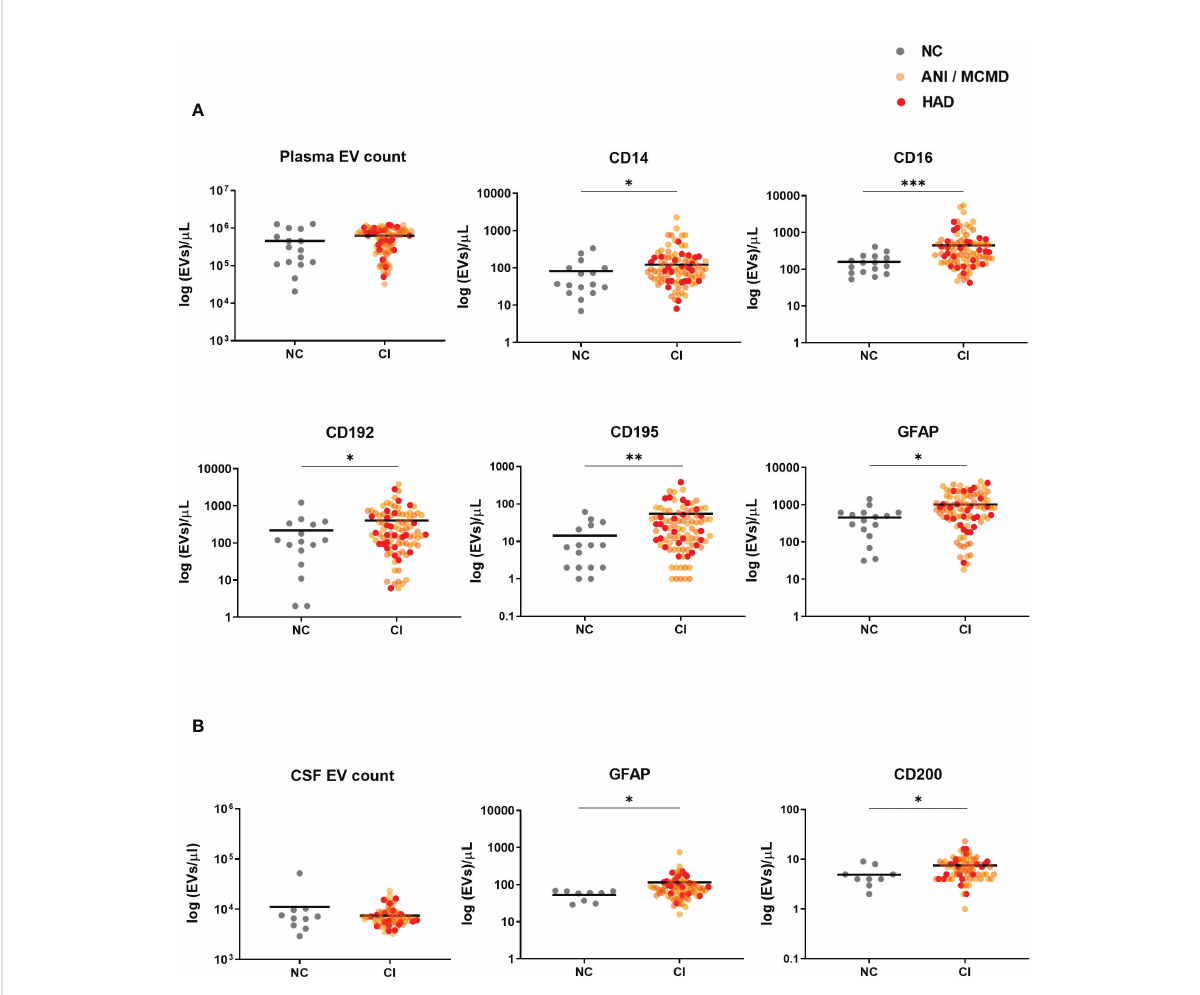
FIGURE 2 Circulating EVs expressing monocyte-associated markers and neuronal damage associate with cognitive impairment in HIV-infected individuals on stable ART. Scatter plots of EVs/µL numbers (log 10-transformed). (A) Plasma-EVs expressing monocyte-associated markers (CD14, CD16, CD192, and CD195) and neuronal damage marker (GFAP) were signi fi cantly higher in HIV+ adults with cognitive impairment (CI) compared to those with normal cognition (NC). (B) There was a signi fi cant increase in levels of CSF-EVs expressing GFAP+ and CD200+ in the CI compared to the NC group. P values were determined by using two-tailed Mann-Whitney test. * P <0.05, ** P <0.01, *** P